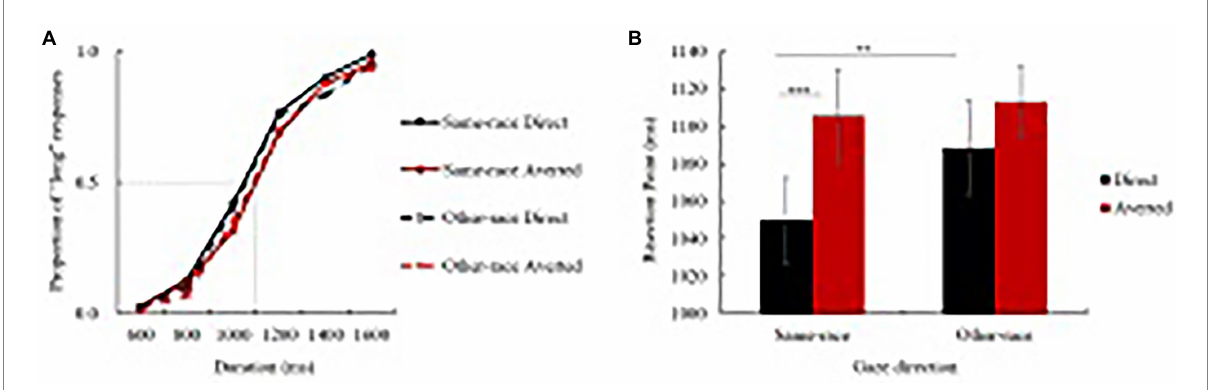
FIGURE 3 Results of the time-bisection task. (A) Psychometric functions fitting the proportion of “long” responses as a function of stimulus duration and gaze direction. The gray dotted line indicates that if the stimuli were perceived as equal to the actual duration, the BP should be 1,100 ms. A left shift of the BP indicates an overestimation of the probe duration, while a right shift demonstrates an underestimation. (B) The bisection point (BP) under each type of stimuli condition. ** p < 0.01, *** p < 0.001. Error bars represent standard error.